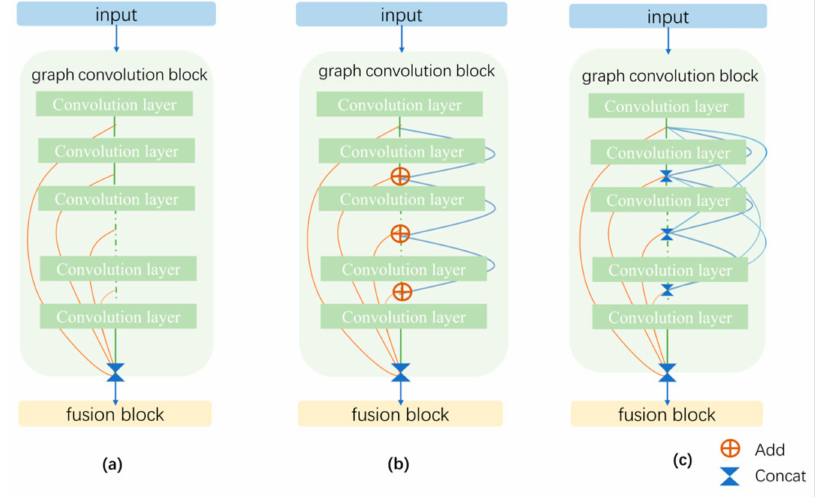
Figure 2. Different ways to connect deep layers: ( a ) JK-Net, ( b ) ResNet, and ( c ) DenseNet.